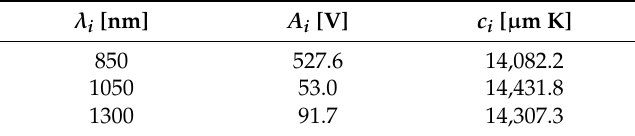
Table 1. Optimum values of the adjustable calibration coefficients, minimising sum of squares of relative errors.